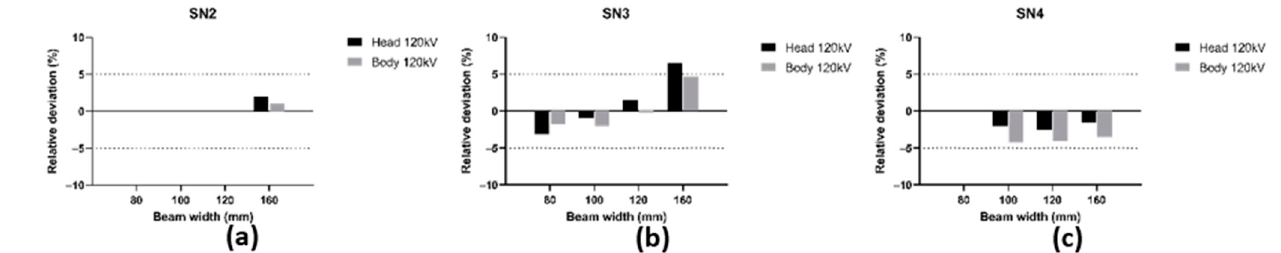
10 of 13 Figure 6. Relative deviation between 𝐶𝑇𝐷𝐼 (cid:3050)(cid:3010)(cid:3023)(cid:3010)(cid:3046)(cid:3030)(cid:3028)(cid:3041) and 𝐶𝑇𝐷𝐼 (cid:3050)(cid:3030)(cid:3035)(cid:3028)(cid:3040)(cid:3029)(cid:3032)(cid:3045) , (cid:4670)∆𝐶𝑇𝐷𝐼(cid:4671) (cid:3045)(cid:3032)(cid:3033)(cid:3010)(cid:3023)(cid:3010)(cid:3046)(cid:3030)(cid:3028)(cid:3041) , at 120 kV for head and body phantoms over the thinnest and the most used beam width in clinic for ( a ) SN1, ( b ) SN2, ( c ) SN3 and ( d ) SN4. Similar results are obtained for beam width > 40 mm except for SN3, at 160 mm, and